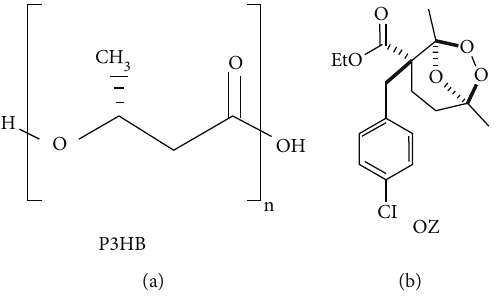
Figure 2: Structures of poly-3-hydroxybutyrate (P3HB) and